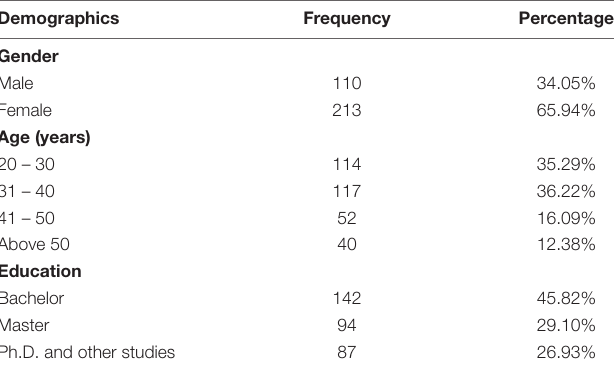
Frontiers in Psychology |